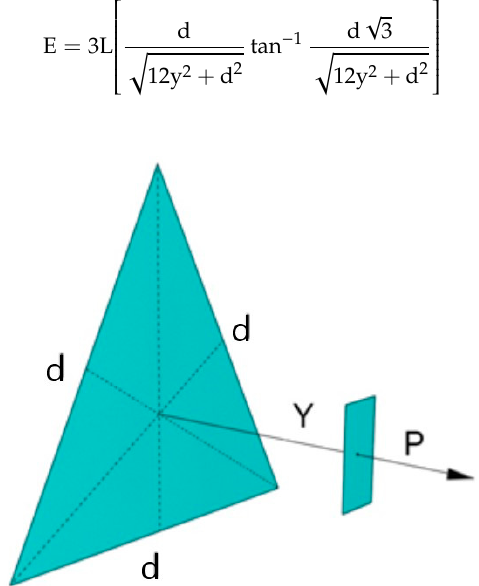
Figure A1. Configuration factor between an equilateral triangle composed of six rotated triangles and a point in a parallel plane.